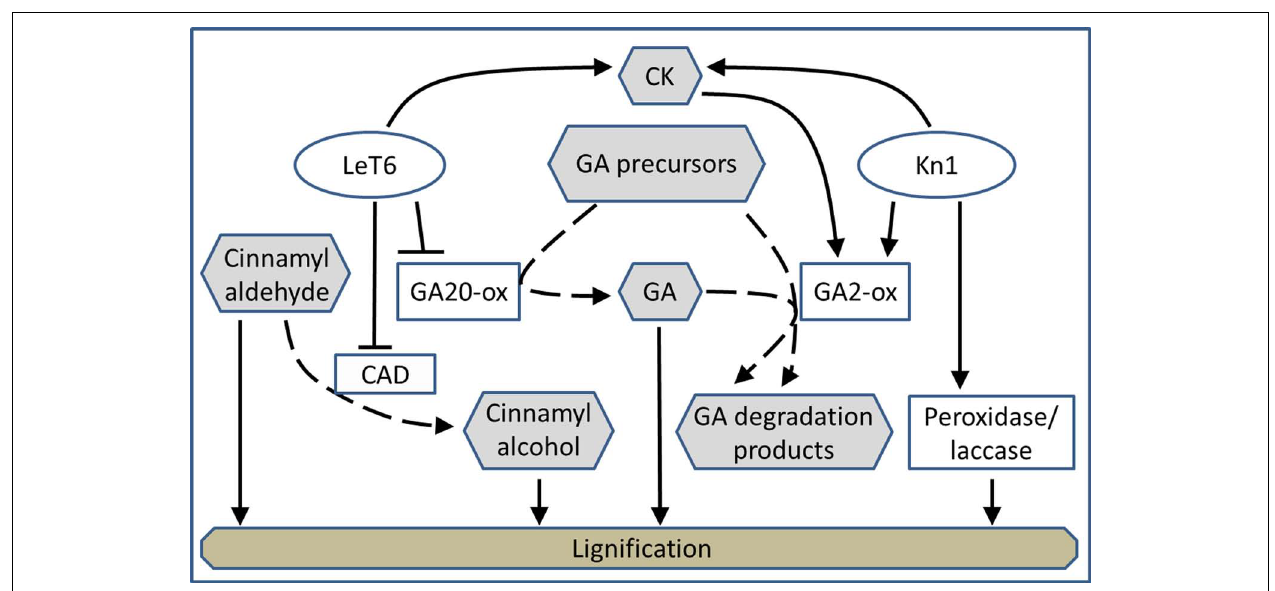
FIGURE 8 | Model depicting the proposed regulatory interactions (solid lines) of LeT6 and Kn1 on gibberellic acid biosynthesis and degradation (dashed